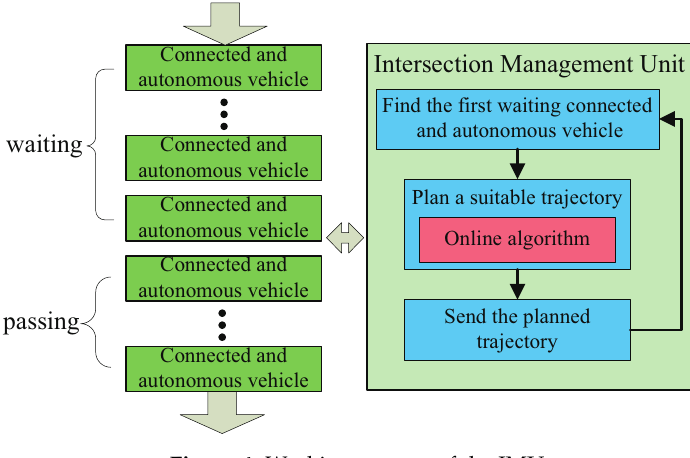
Figure 4. Working process of the IMU.